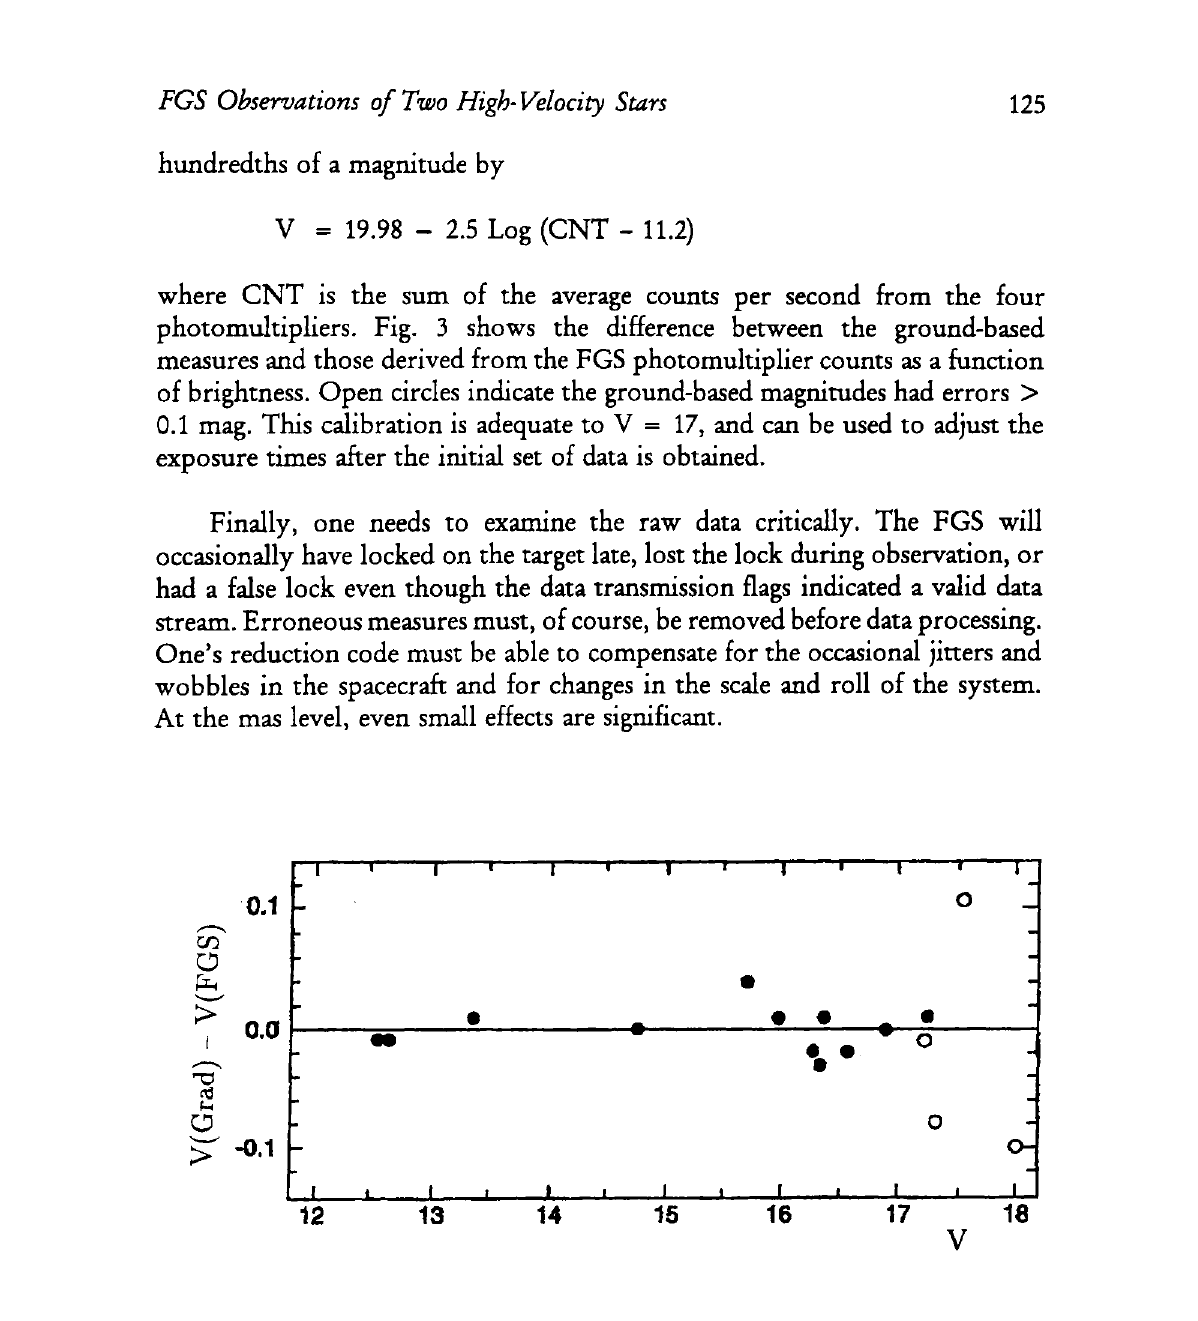
Fig. 3. Difference between the ground-based and FGS-determined V